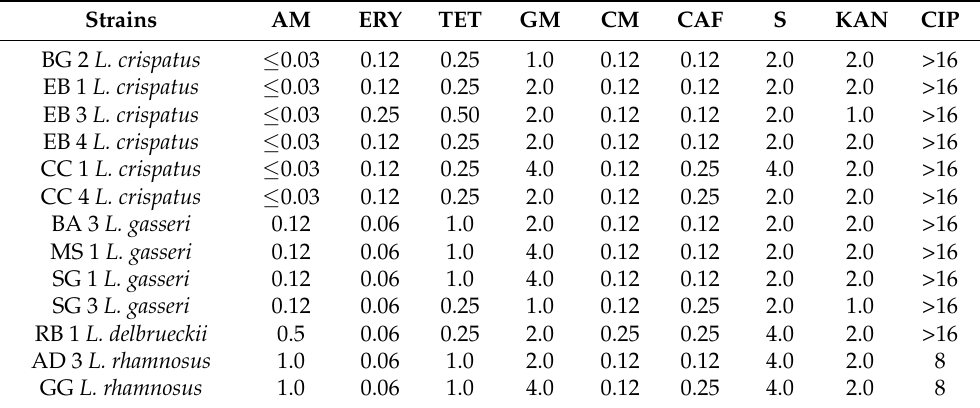
Table 1. MIC values expressed as µ g mL − 1 for the evaluation of antibiotic resistance of the Lactobacillus